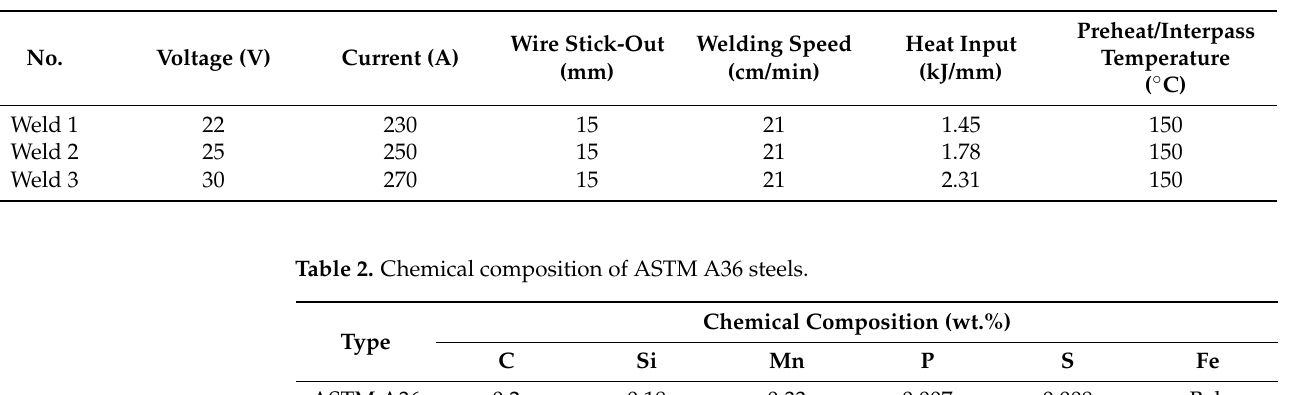
Table 1. Welding parameters used in experiments.